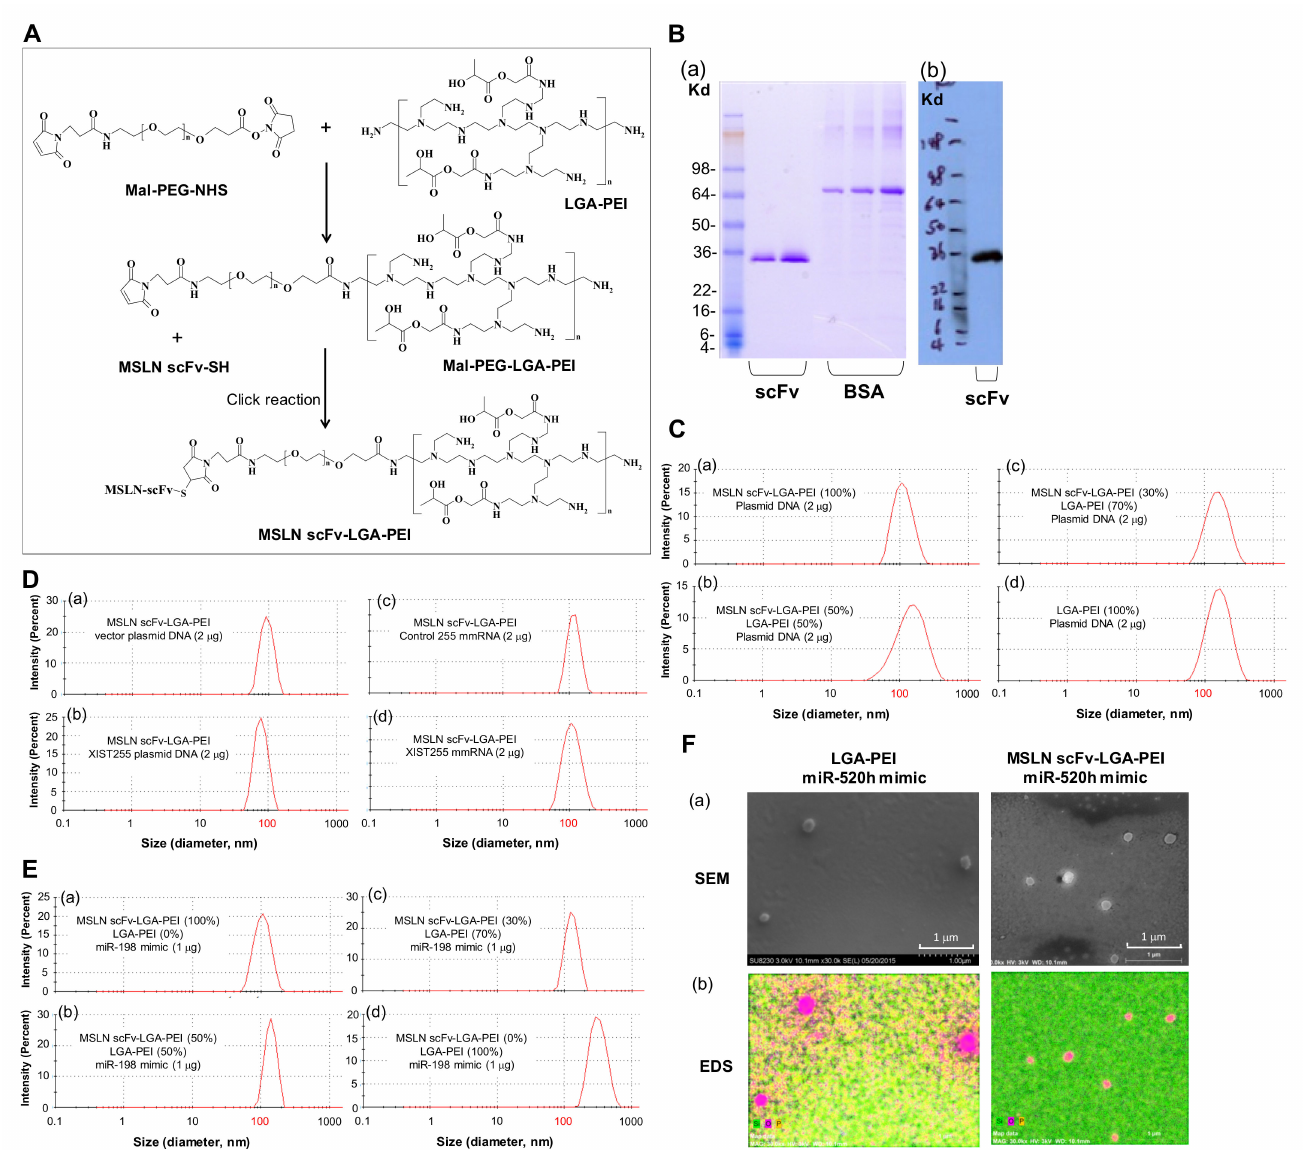
Figure 1. Synthesis of MSLN scFv-LGA-PEI and nanoparticle (NP) formation with different types of nucleic acids. ( A ) Pro- posed mechanism for the conjugation of MSLN scFv to LGA-modified PEI polymers. Bi-functional PEG (Mal-PEG-NHS) was used to covalently link to the MSLN scFv fragment through a click reaction. ( B ) Recombinant MSLN scFv was produced from the yeast expression system. ( a ) SDS Page and Coomassie blue staining showing MSLN scFv. ( b ) Western blot (anti-His Ab) showing the molecular weight of MSLN scFv (about 30 kDa). ( C ) Effect of different MSLN scFv-LGA-PEI and LGA-PEI ratios on the size of NP formation with plasmid DNA ( a – d ). Average sizes are listed in Supplementary Table S3. ( D ) NP sizes formed from of pure MSLN scFv-LGA-PEI (5 µ g) with 2 µ g vector plasmid (double-stranded, circular DNA, 3.2 kbp) ( a ), XIST255 gene containing plasmid DNA ( b ), XIST255 mmRNA (single-stranded RNA, 255 bases) ( c ) or control mmRNA ( d ). ( E ) The size distribution of NP formation from two polymers, MSLN scFv-LGA-PEI and LGA-PEI at different ratios ( a – d ) with miR-198 mimics (double-stranded, 23 bp). Average sizes are listed in Supplementary Table S4. ( F ) Scanning electronic microscopy (SEM) and energy-dispersive spectroscopy (EDS) analysis of LGA-PEI/miR-520h mimics NPs, and MSLN scFv-LGA-PEI/miR-520h mimics. ( a ) SEM images. ( b ) EDS composition map (oxygen element in purple and phosphorus element in yellow